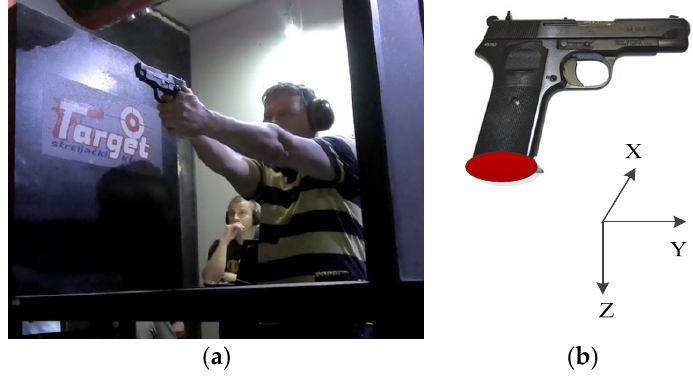
Figure 10. Precise shooting measurements: ( a ) in our precision shooting experiment, trainees need to use both hands to support the pistol model; ( b ) the orientation of the sensor coordinate system.